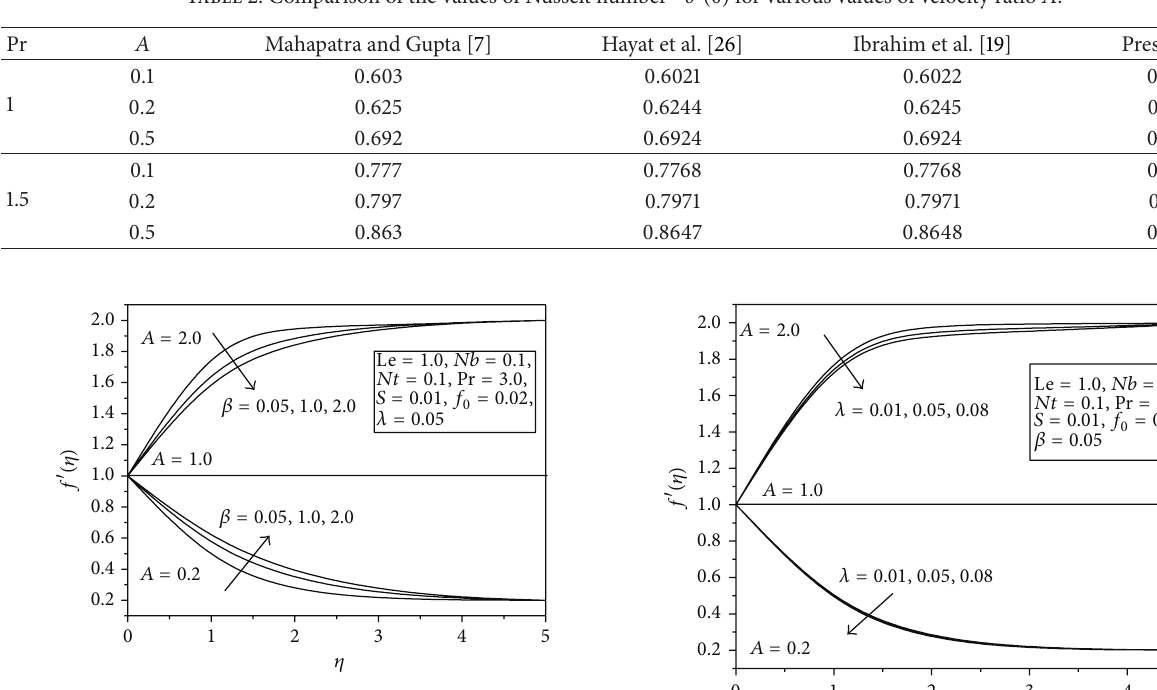
Figure 5: Velocity profile for different values of 𝛽 .